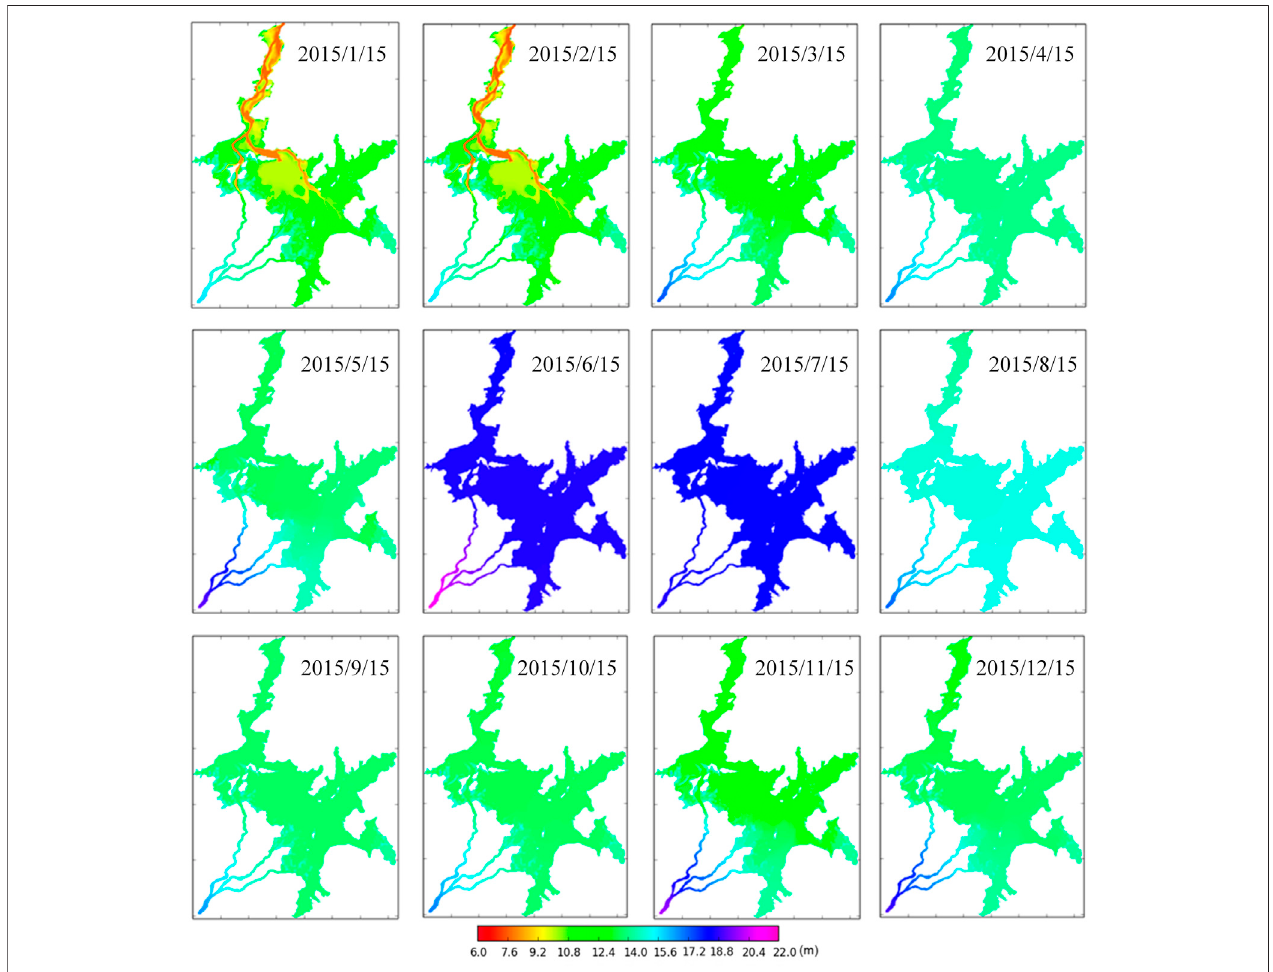
FIGURE 2 | Spatiotemporal distributions of the simulated water levels of Lake Poyang in 2015.